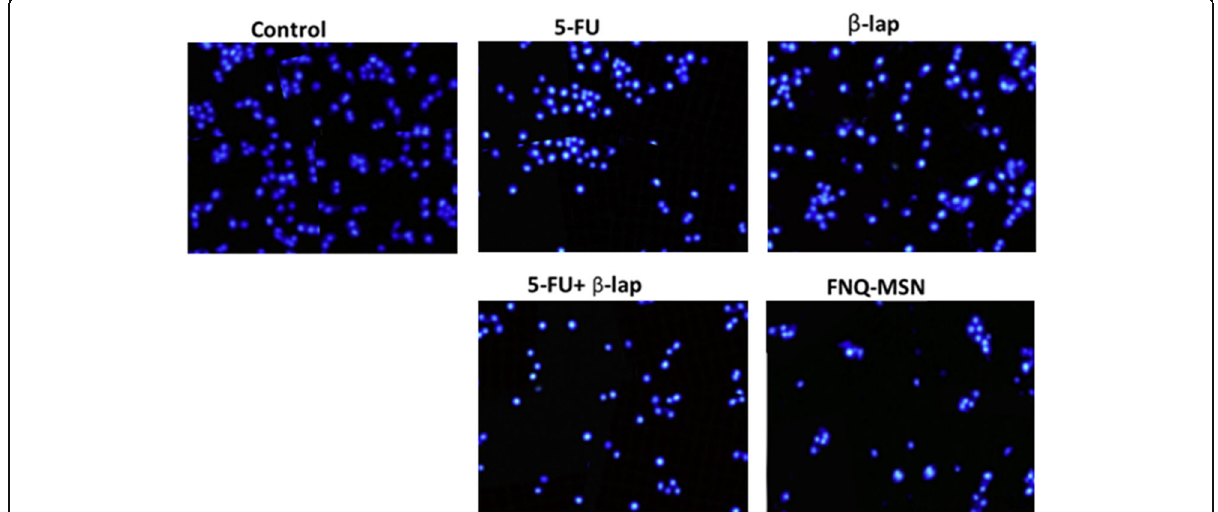
Fig. 6 Nuclear morphology analysis of Cal33 cells after staining with Hoechst 33342; cells were treated with individual and combination of 5-FU and ß-lap. 10,000 events were recorded in the flow cytometer